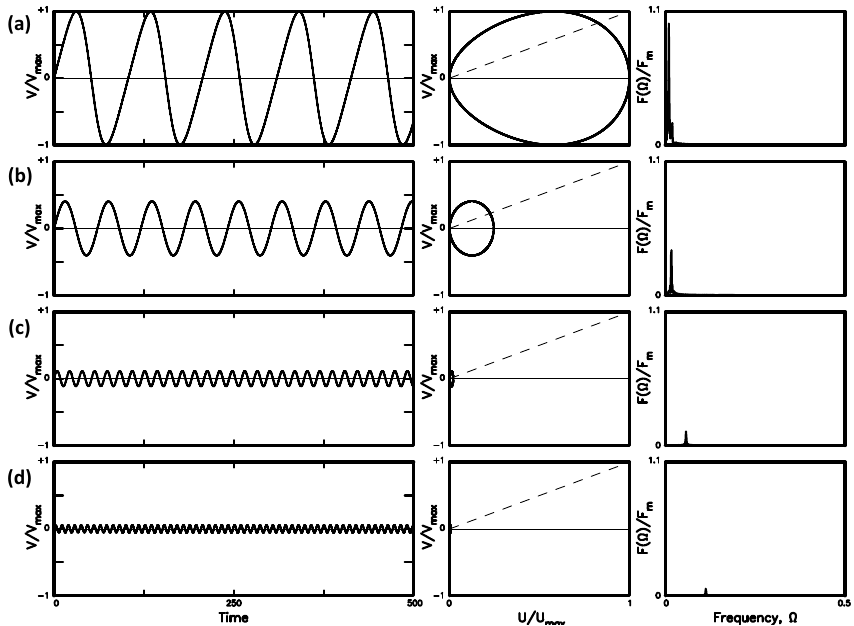
Figure 6. The time variation in V/V max , the phase portrait of V/V max versus U/U max , and the power spectrum for four values of U c : (a) for U c = 1 . 00; (b) for U c = 1 . 01; (c) for U c = 1 . 15; and (d) for U c = 2 . 00 for the TP law of F(U) = exp ( − U/U c ) when η =